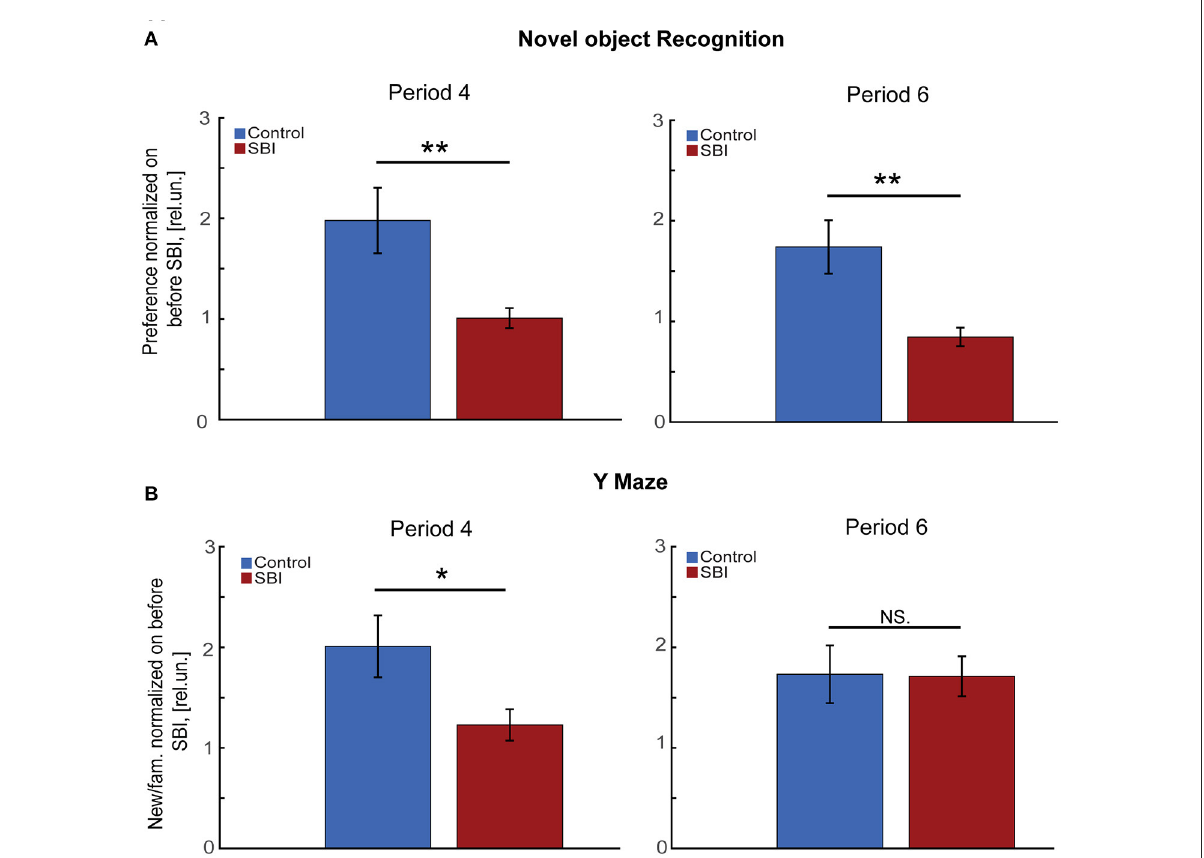
FIGURE3 SBI chronically affects memory tasks. (A) Novel object preference by control ( n = 22) and SBI mice ( n = 30) exploring a novel object 1 (period 4) and 4 weeks (period 6) after SBI. Data were normalized to novel object preference before injury and shown in relative units (rel.un.). We applied the Mann–Whitney U test for a two-group comparison. (B) Exhibits the preference of control ( n = 22) and SBI mice ( n = 30) for the “new” arm of the Y Maze as the time spent in the “new” arm vs. “familiar” (fam.) arm ratio at a week and 4 weeks respectively. Data were normalized to Y Maze execution before SBI and, therefore, represented in relative units. Since the data was non-parametric, we applied the Mann–Whitney U test for two-group comparison * p < 0.05, ** p < 0.01, and non-significant statistical differences (N.S).